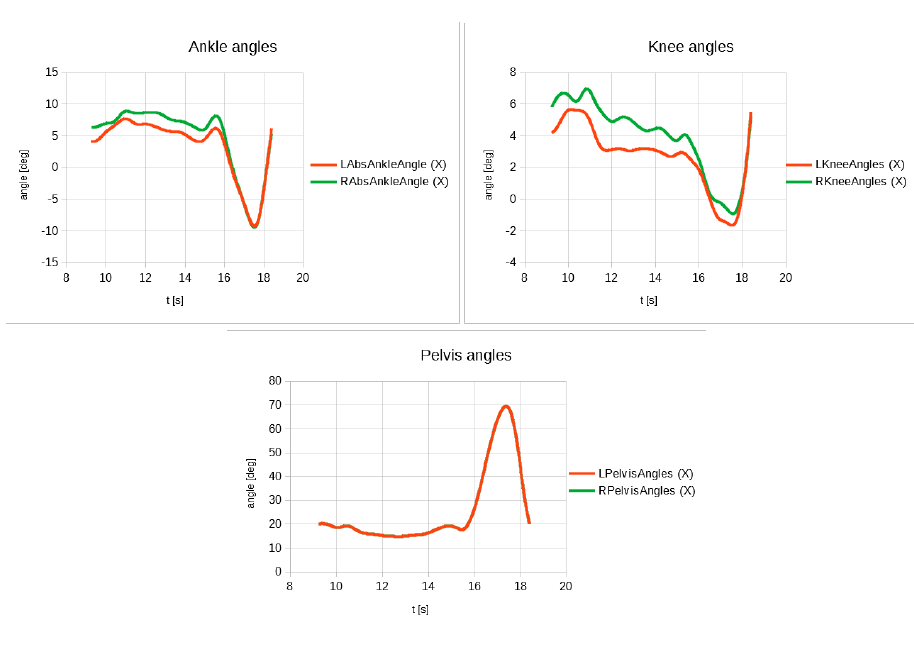
Figure 8. Angles for lower body parts for the first